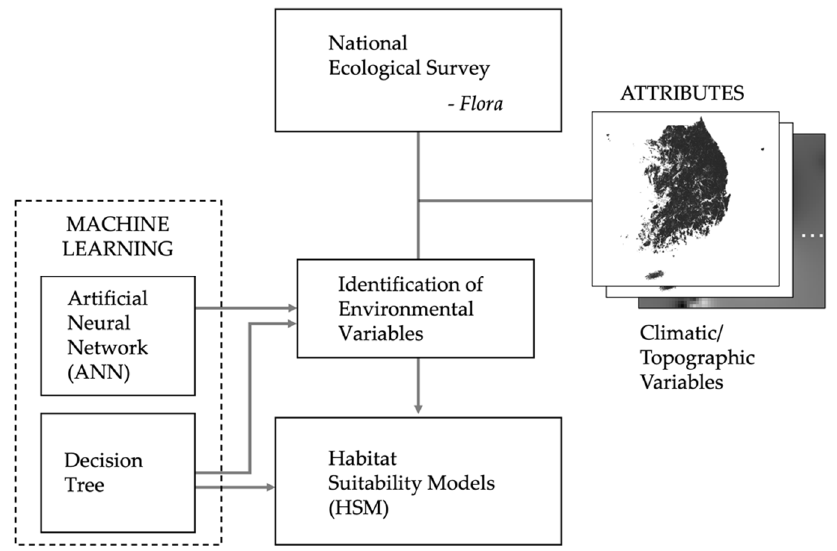
Figure 2. Modeling process.